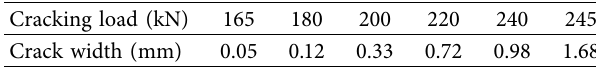
Table 7: Crack development of the test beam.